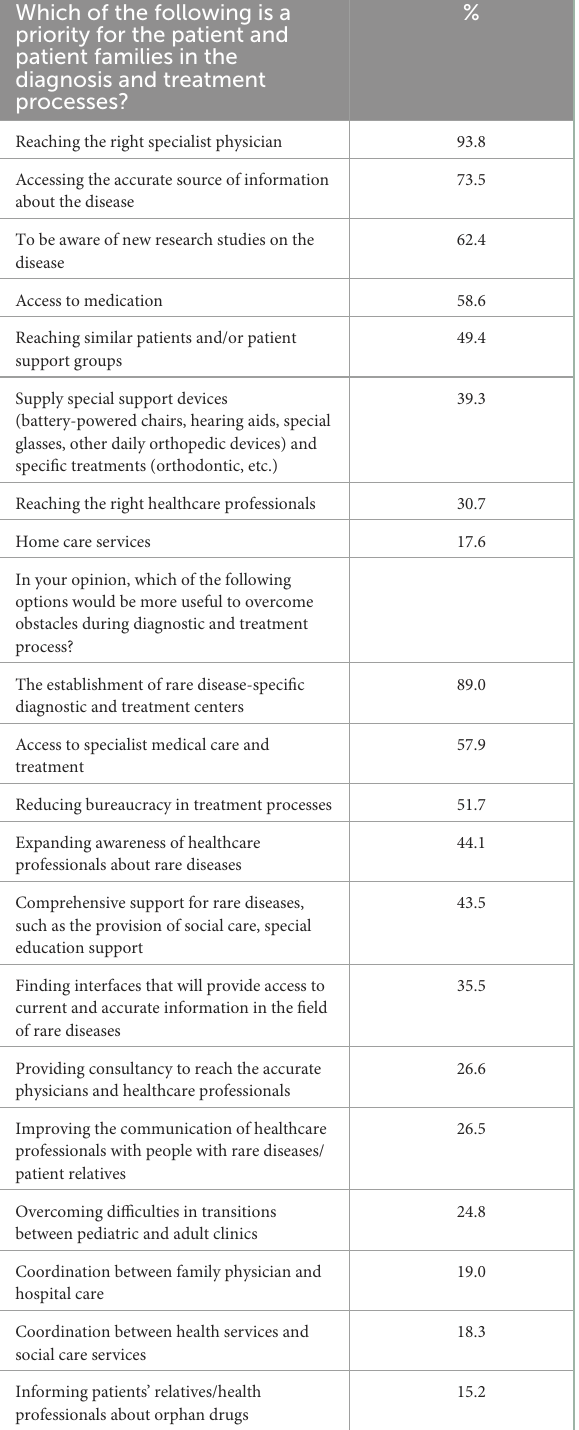
TABLE 6 Major problems faced by the patient when dealing with a rare disease. What are the major problems faced by the patient when